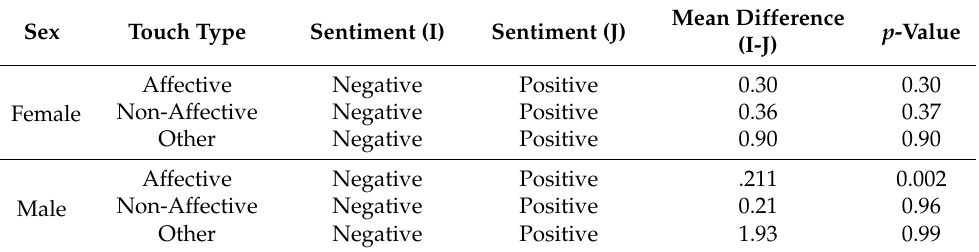
Table 6. Sex Comparison Between Physiological Arousal Change in Positive and Negative Utterances by